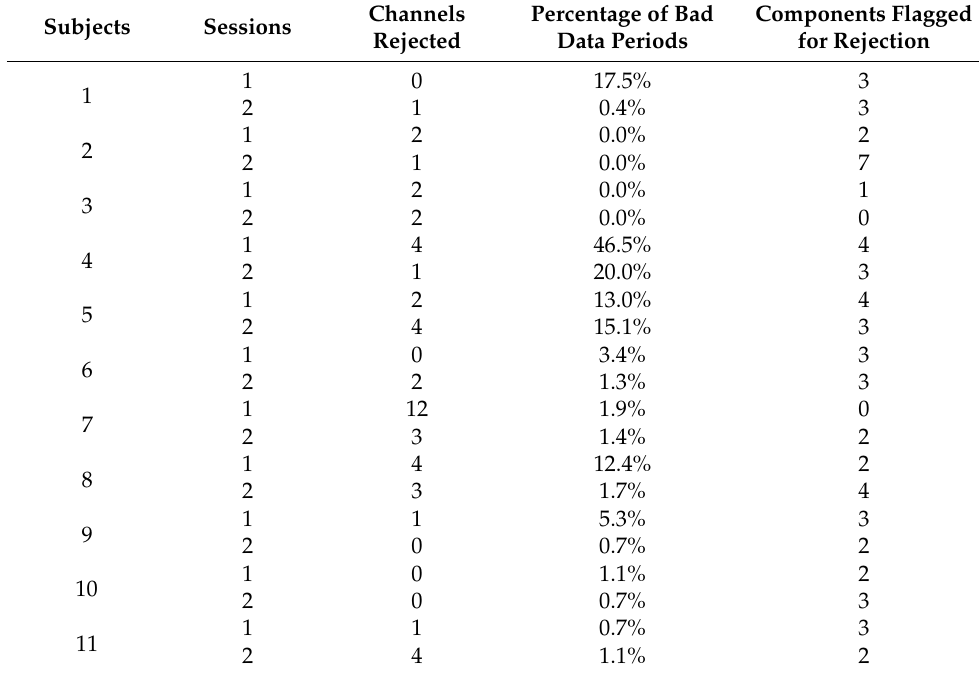
Table A1. Rejected channels, the percentage of bad data periods with transient or large-amplitude artifacts, and the independent components distinguished as non-brain